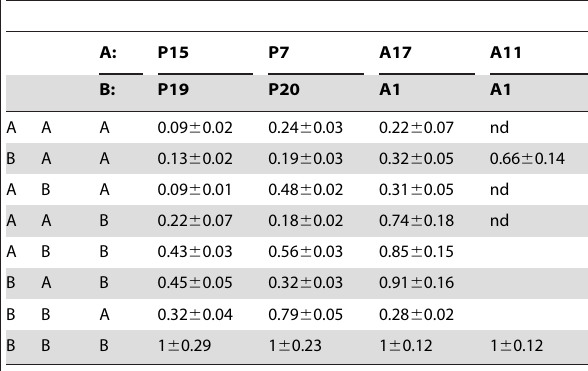
Table 1. Expression of 4 chimeric gene